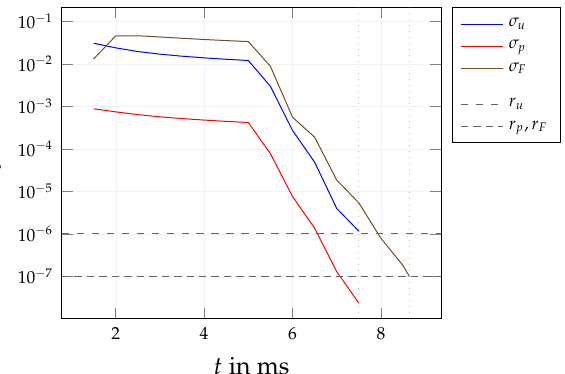
Figure 13. Transient development of velocity, pressure and force convergence for an inflow velocity of ¯ u in = 20ms − 1 with a resolution of N = 96. Dashed lines represent residuals r u , r p and r F . Dotted lines indicate time of flow and force